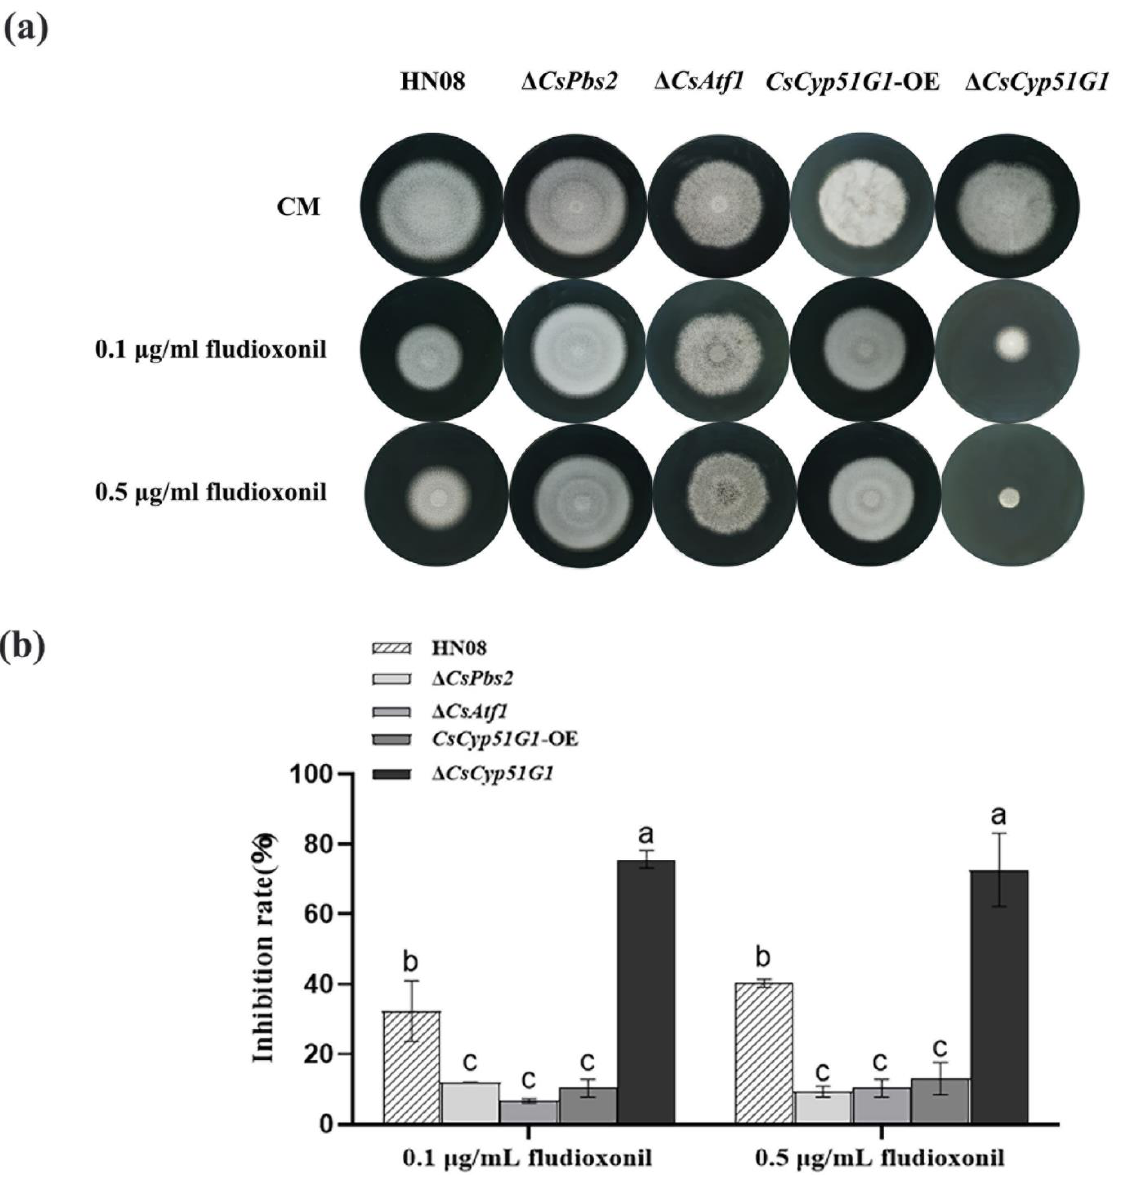
Figure 5. Comparison of fludioxonil resistance among the WT strain HN08, Δ CsPbs2 , Δ CsAtf1 , CsCyp51G1-OE, and Δ CsCyp51G1 . ( a ) Mycelial growth of the tested strains cultured in CM containing different concentrations of fludioxonil for 5 d. ( b ) Growth inhibition rate of the tested strains under different concentrations of fludioxonil. The growth inhibition rate is relative to the growth rate of each untreated control [(diameter of untreated strain − diameter of treated strain)/(diameter of untreated strain × 100%)]. Three repeats were performed. The error bars show the SD value, and different letters indicate significant difference at p < 0.01 (One- way ANOVA and Duncan’s test ).